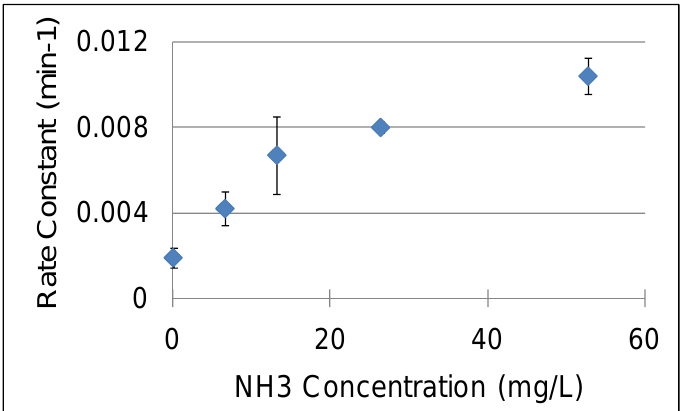
Figure 16. Evaluated rate constants of cinnamaldehyde hydrolysis to benzaldehyde with concentrations and 240 °C different NH 3